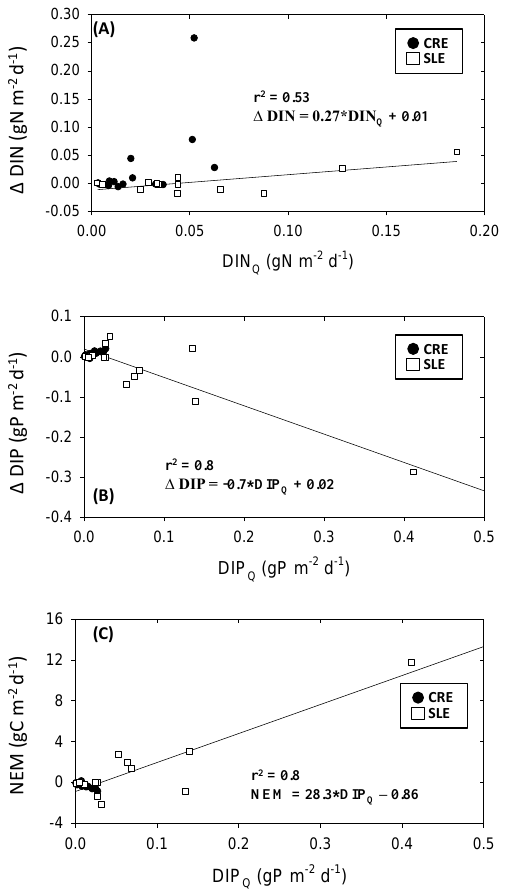
and SLE from 2002 to 2008. (A) 1 DIN (g Nm − 2 d − 1 ) ; (B) 1 DIP (g Pm − 2 d − 1 ) ; (C) NEM (g Cm − 2 d − 1 ) . External DIN load (g N m − 2 d − 1 ) or DIP load (g Pm − 2 d − 1 ) provided the independent variable. Regression lines, r 2 values, and equations provided for the SLE points